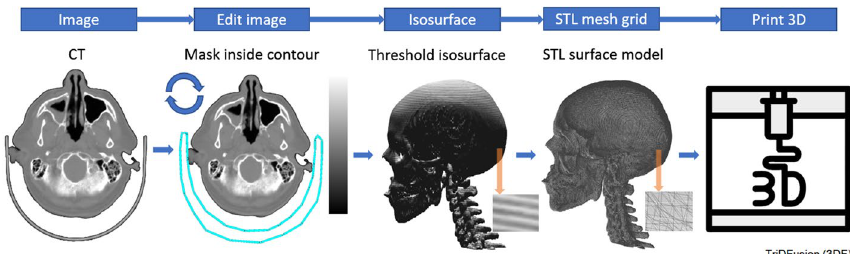
Fig. 17 Three-dimensional (3D) printing workflow using a computed tomography (CT)